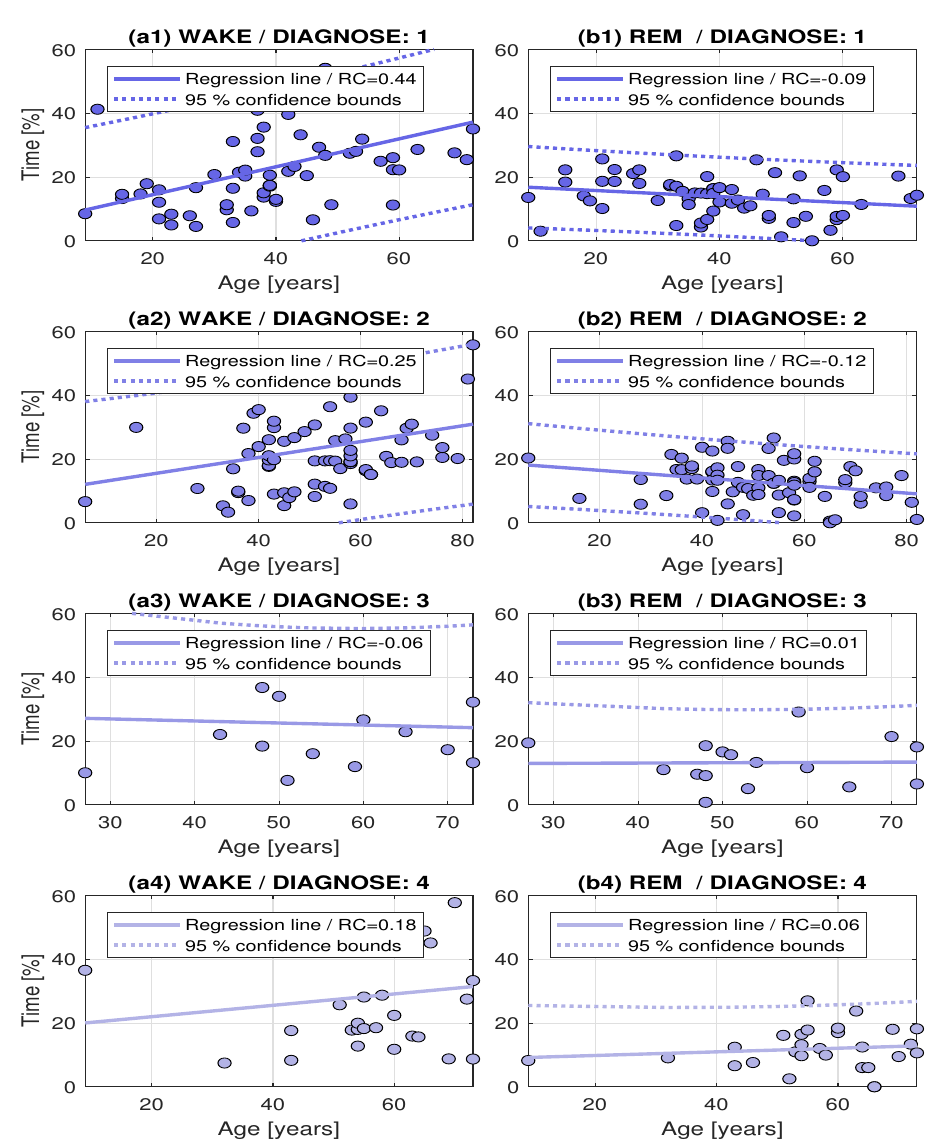
Figure 6. Distributions of Wake and REM sleep stages related to age for ( a1 , b1 ) healthy individuals and patients with ( a2 , b2 ) sleep apnea; ( a3 , b3 ) restless leg syndrom; and ( a4 , b4 ) restless leg syndrom and sleep